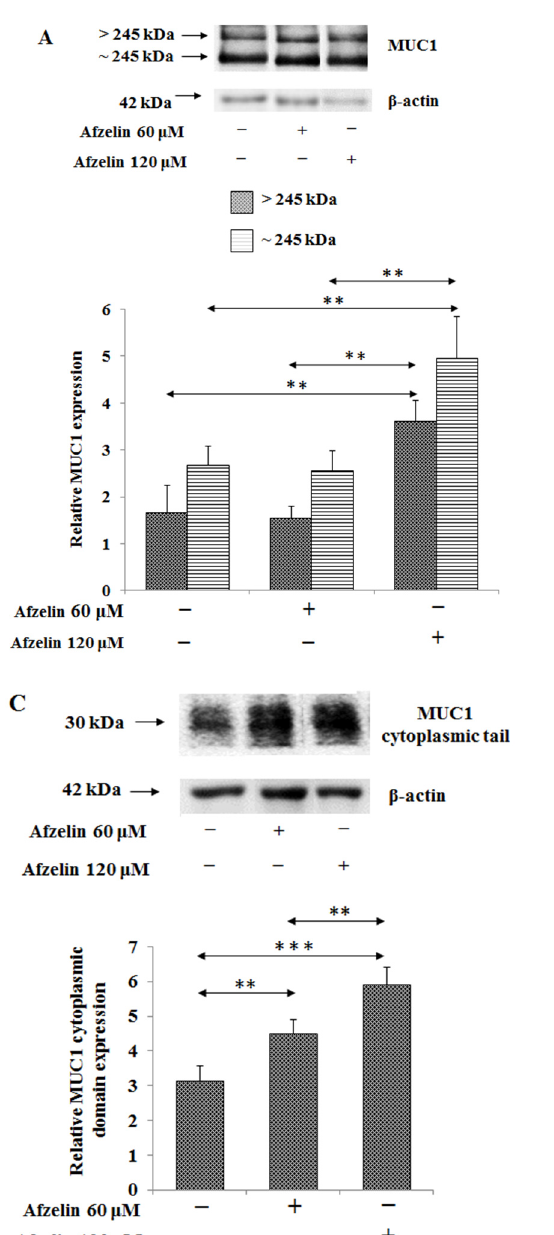
cells with both concentrations of the flavonoid in comparison to control (Figure 6B, sup- plementary Figure S1). Cytoplasmic domain of MUC1 with 30 kDa molecular mass was significantly increased by afzelin treatment, in concentration dependent manner by 43 and 88%, respectively (Figure 6C, supplementary Figure S1). It was also found that 120 μ M (Figure 6C, supplementary Figure S1). It was also found that 120 µ M afzelin exerted by 37% stimulatory effect on MUC1 mRNA expression (Figure 6D).